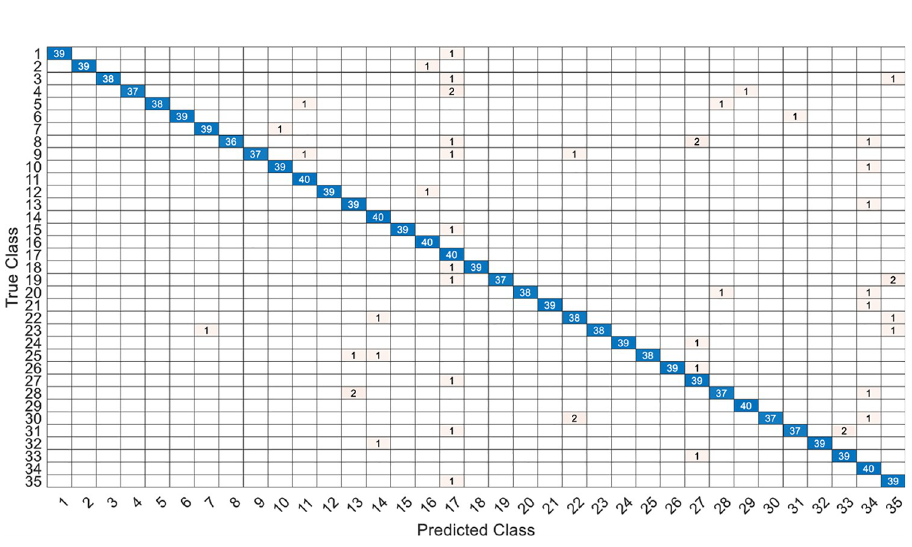
Fig 38. The confusion matrix of PCA-LSTM-2 × 200 model with MFCC datasets.